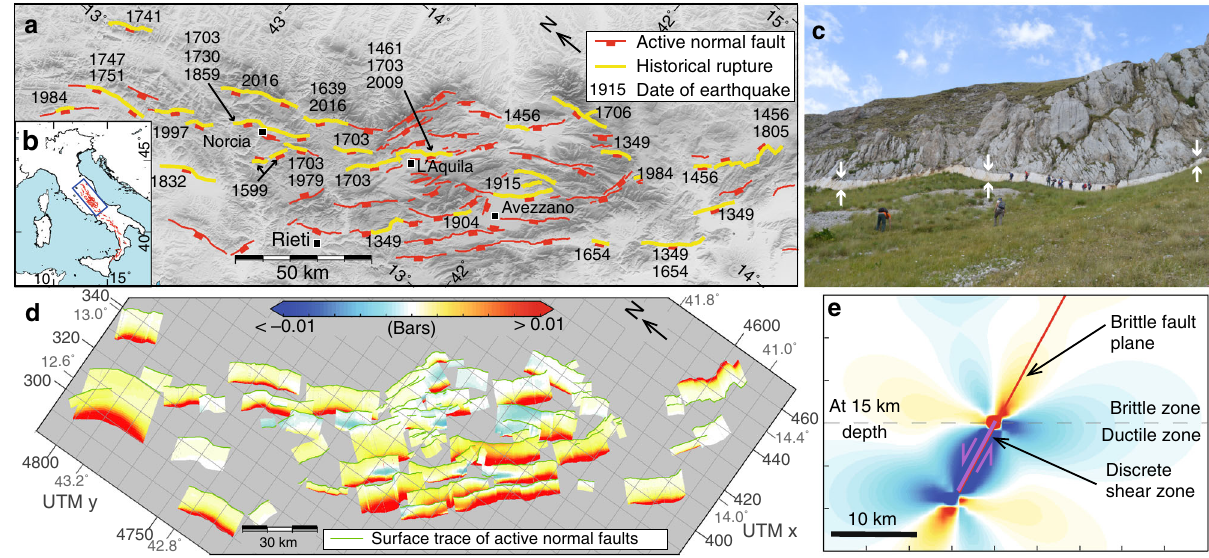
Fig. 1 Summary of input data for this study. a Fault map of the central Apennines 62,63 . Towns are shown with black squares and are labeled. b Blue box shows the location of the study area within Italy. c Field photo of the coseismic rupture from two earthquakes in 2016 that both occurred on the Mt. Vettore fault. White arrows show the top and bottom of the coseismically exhumed fault scarp. d Heterogeneous annual interseismic loading rate on the brittle portions of non-planar faults from underlying ductile shear zones (not shown in fi gure). e Cross-section of shear zone model and associated Coulomb stress transfer (CST) for annual interseismic loading. Colour scale is the same as